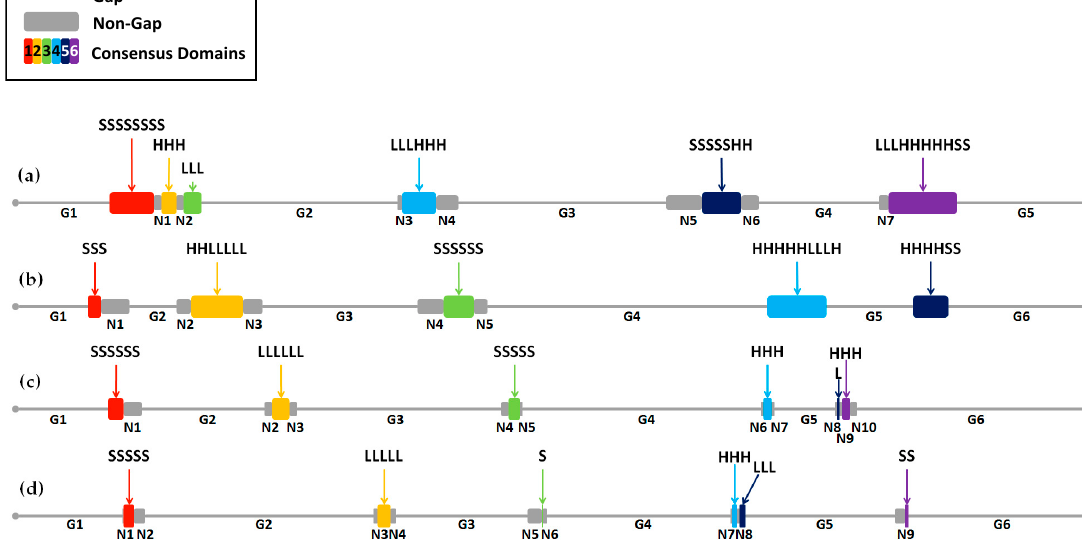
Figure 4. Linear representation of MSS$A that includes all gaps (G1, G2, etc.); non ‐ gaps (N1, N2, etc.) and SS$ defining a given secondary structure consensus domain based on all ( a ) dominant ‐ only structures for AuNR aptamers; ( b ) dominant + suboptimal structures for AuNR aptamers; ( c ) dominant ‐ only structures for a random sequence population background; and ( d ) dominant + suboptimal structures for a random sequence population.